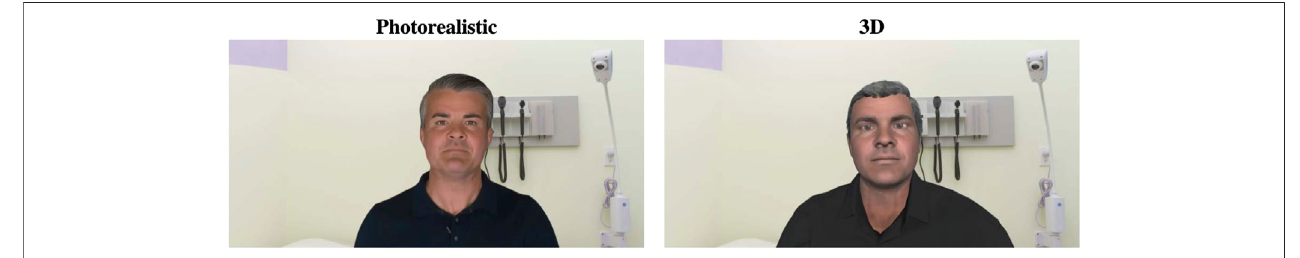
FIGURE 2 | The photorealistic rendering style (Left) and the 3D rendering style